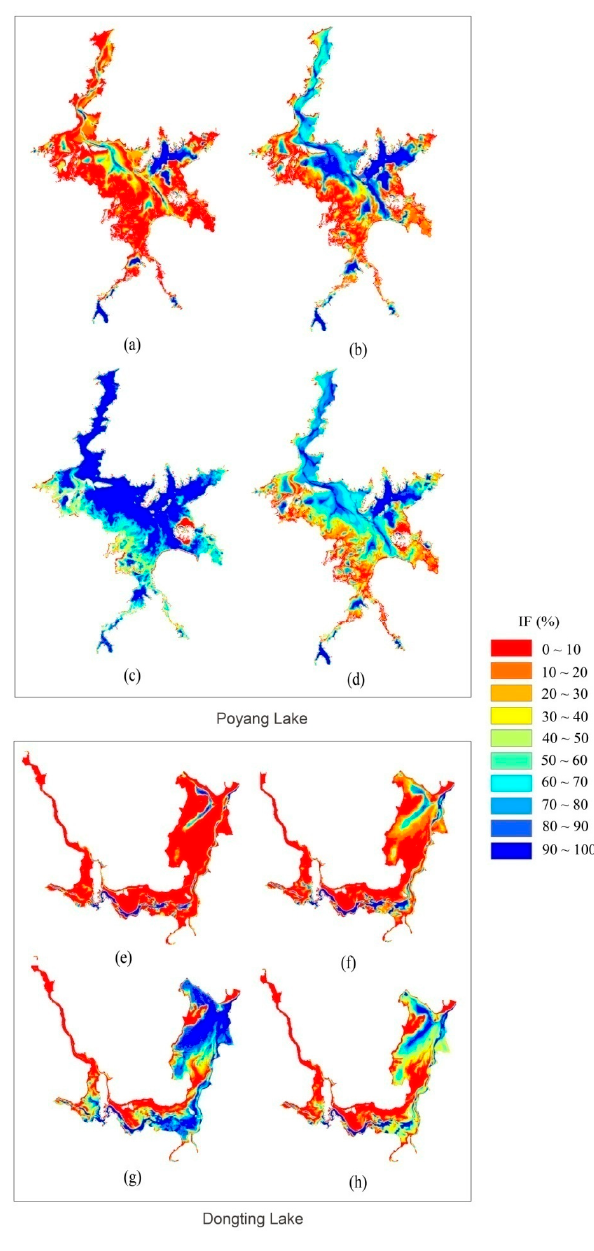
Figure 7. Maps of the evolution of the mean inundation frequency for the two lakes during the different water regime periods: ( a – d ) Poyang Lake in the low-water, rising, high-water and retreating periods, respectively; and ( e – h ) Dongting Lake in the low-water, rising, high-water and retreating periods, respectively.